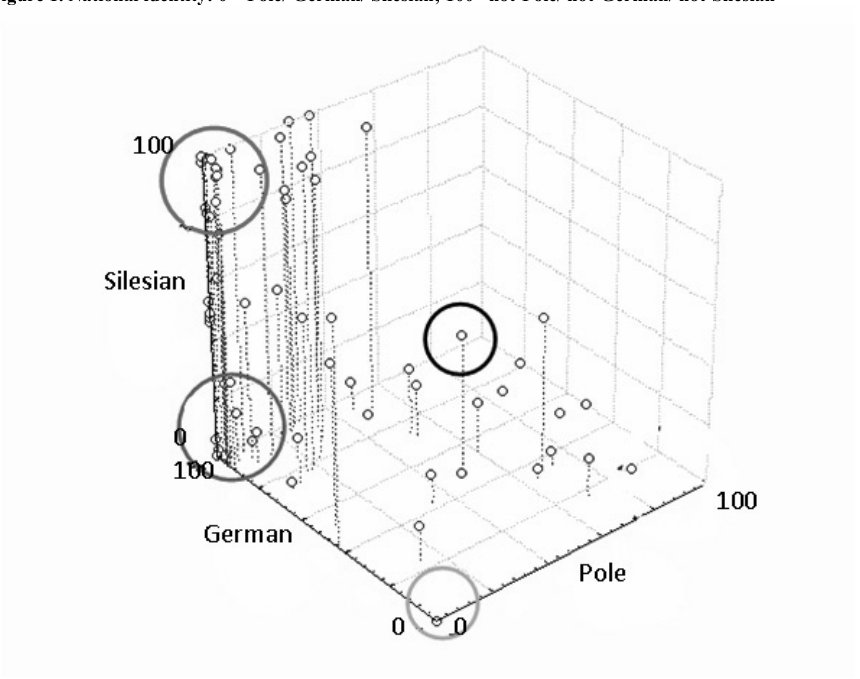
Figure 1. National identity: 0 – Pole/ German/ Silesian; 100 –not-Pole/ not-German/